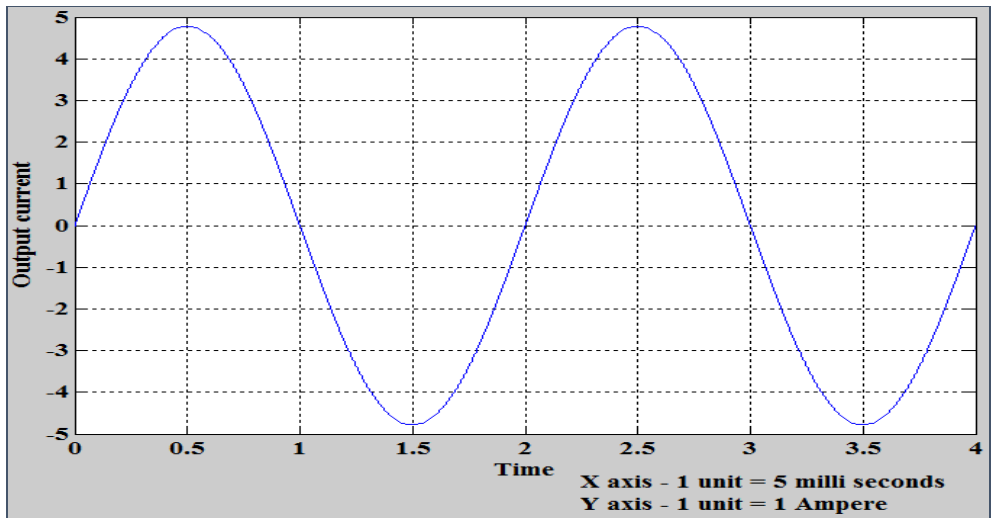
Figure 17. Output current vs. Time—R load (50 ohm)—Simulation.